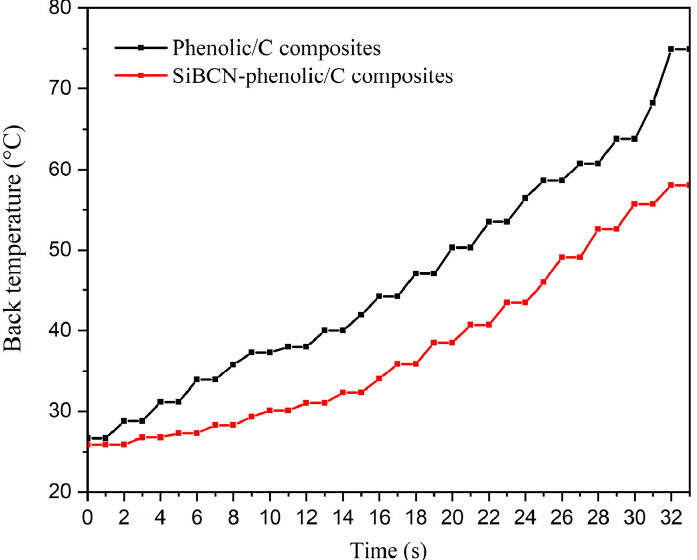
Figure 11. Back temperature of SiBCN–phenolic/C and phenolic/C composites.